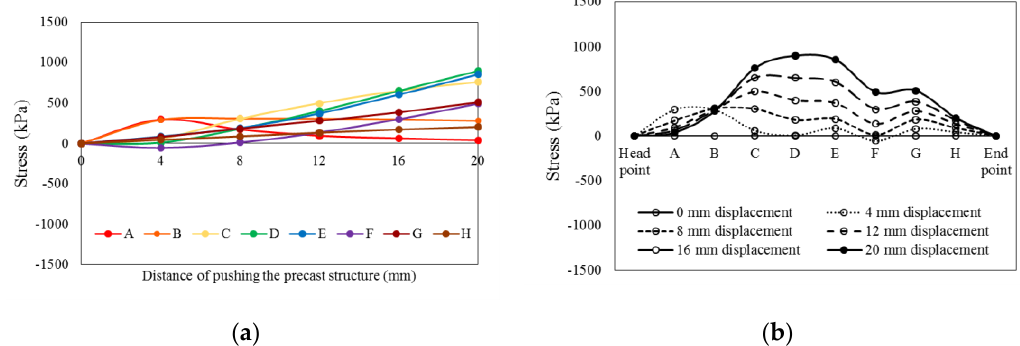
Figure 8. Variation in stress acting on piles in case of type 1 with shoe structure at cover depth of 125 mm during Stage 1: ( a ) based on strain gauges. ( b ) Based on distance of pulling back the pressure panel.